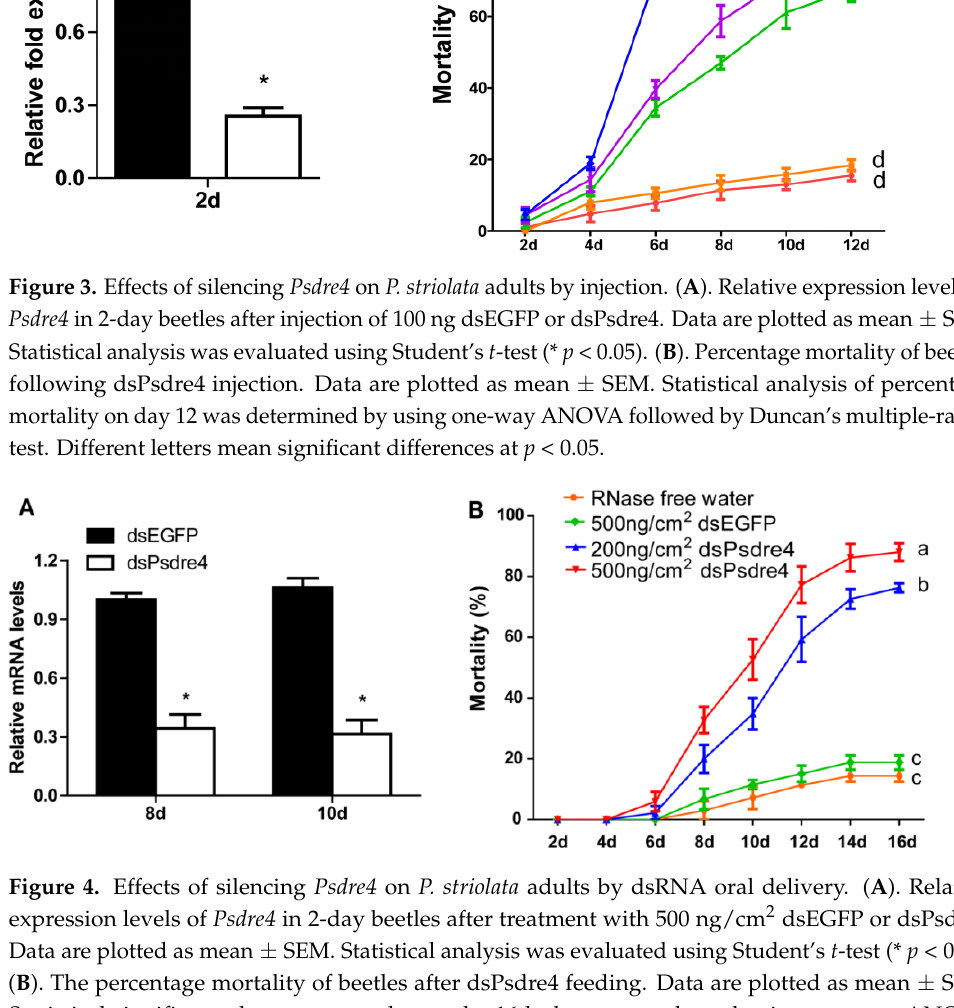
Figure 3. Effects of silencing Psdre4 on P. striolata adults by injection. ( A ). Relative expression levels of Psdre4 in 2-day beetles after injection of 100 ng dsEGFP or dsPsdre4. Data are plotted as mean ± SEM. Statistical analysis was evaluated using Student’s t -test (* p < 0.05). ( B ). Percentage mortality of beetles following dsPsdre4 injection. Data are plotted as mean ± SEM. Statistical analysis of per- centage mortality on day 12 was determined by using one- way ANOVA followed by Duncan’s mul- tiple-range test. Different letters mean significant differences at p < 0.05.